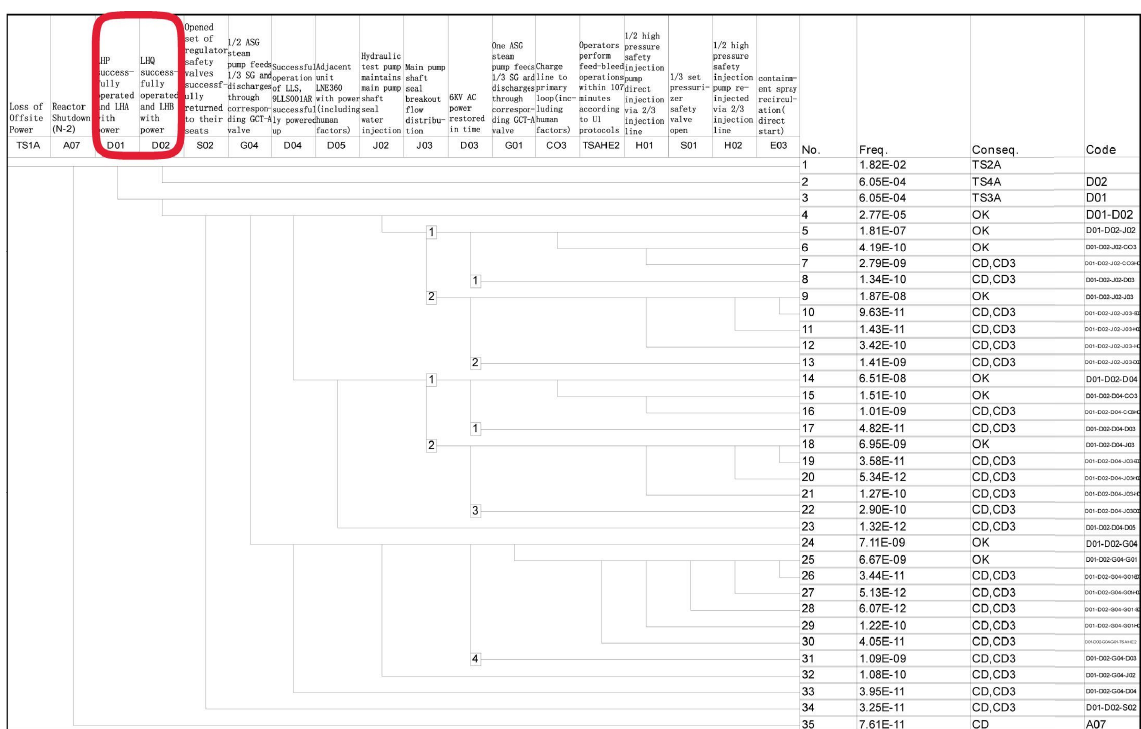
Figure 3: An NPP’s LOOP event tree model.